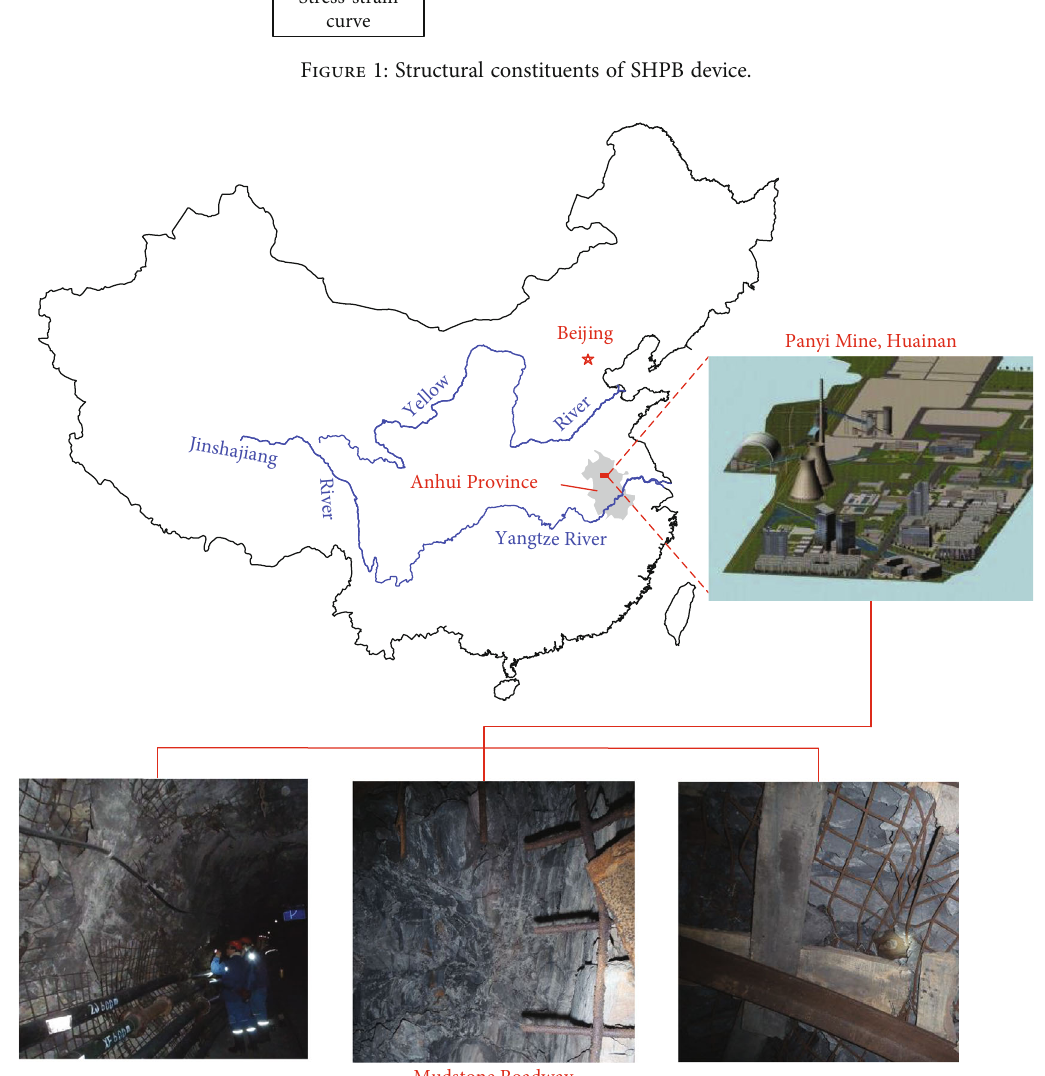
Figure 2: Specimen location: Panyi mining area, Huainan, China.